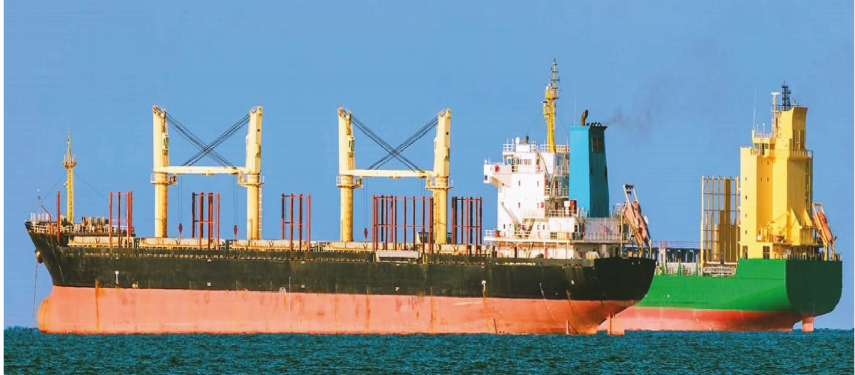
Figure 2: Offshore vessels.